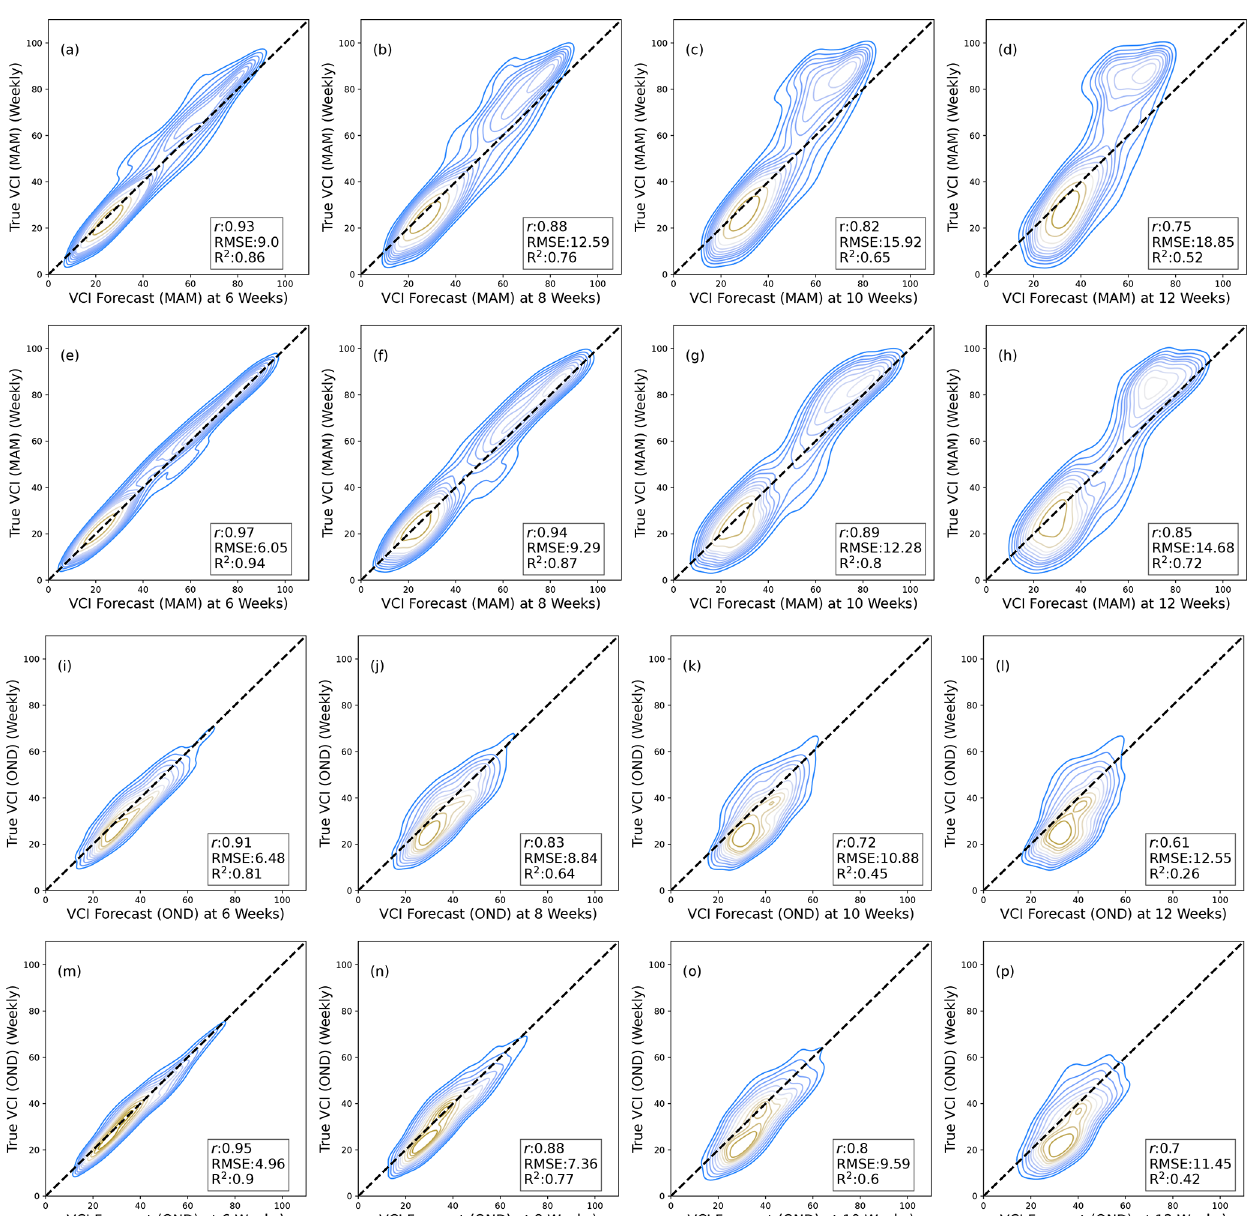
Figure D1. Contour plots showing VCI3M forecast against true VCI3M for MAM and OND seasons. Panels (a) – (d) show the results from the AR method with VCI3M only, and (e) – (h) show the overall results for BARDL modelled with lags of VCI3M plus lags of precipitation (P3M) and soil moisture (S3M) anomalies for 6-, 8-, 10-, and 12-week lead time for all